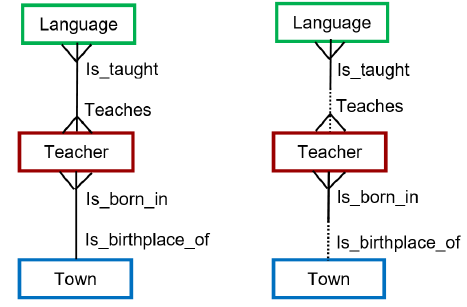
Fig. 3: (a) Graph C-schema 1. (b) Graph C-schema